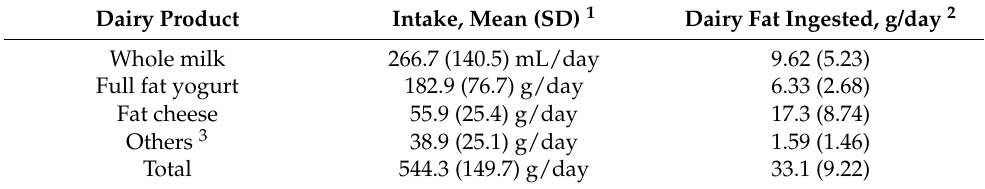
Table 1. Intake of dairy products and fat from dairy products by participants in the intervention